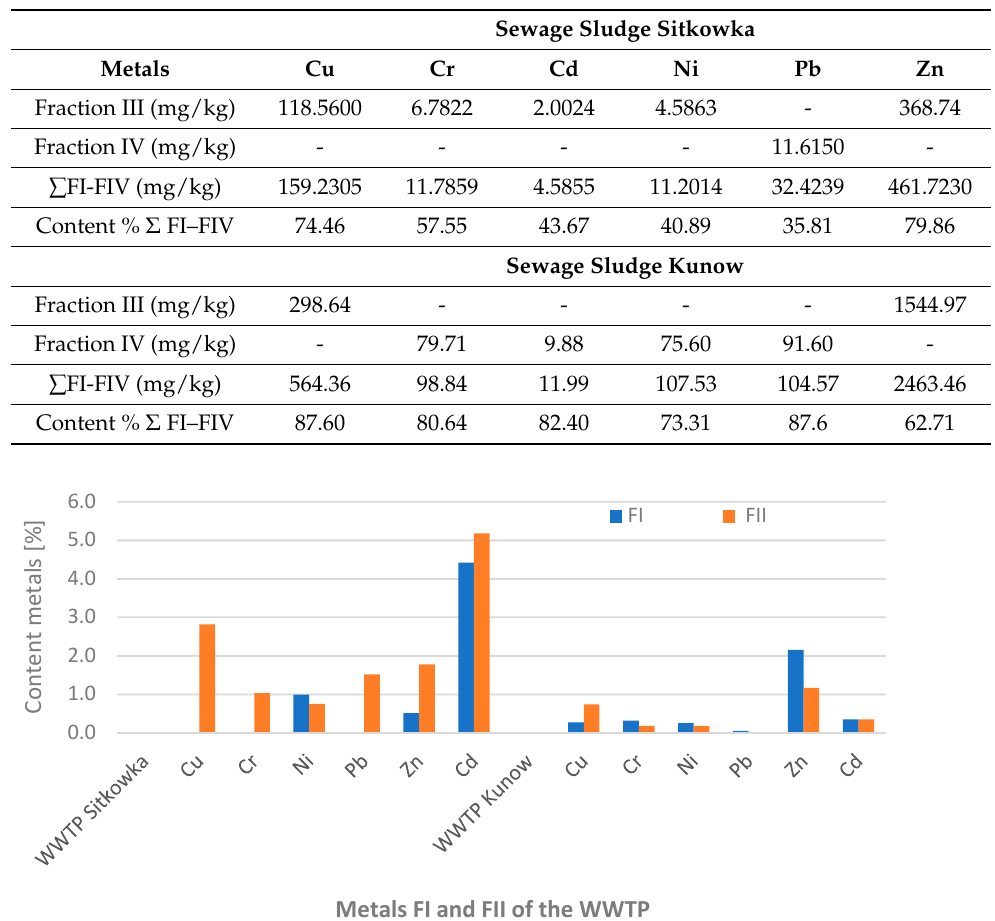
Table 7. Percentage % of metals in the sludge in the FIII and FIV fractions in relation to the total content of Σ FI–FIV.